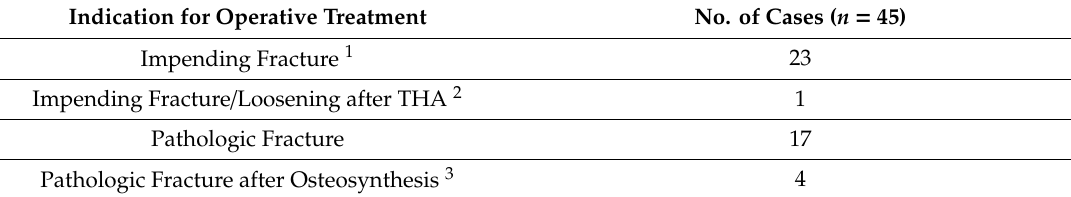
Table 2. Indication for operative treatment.